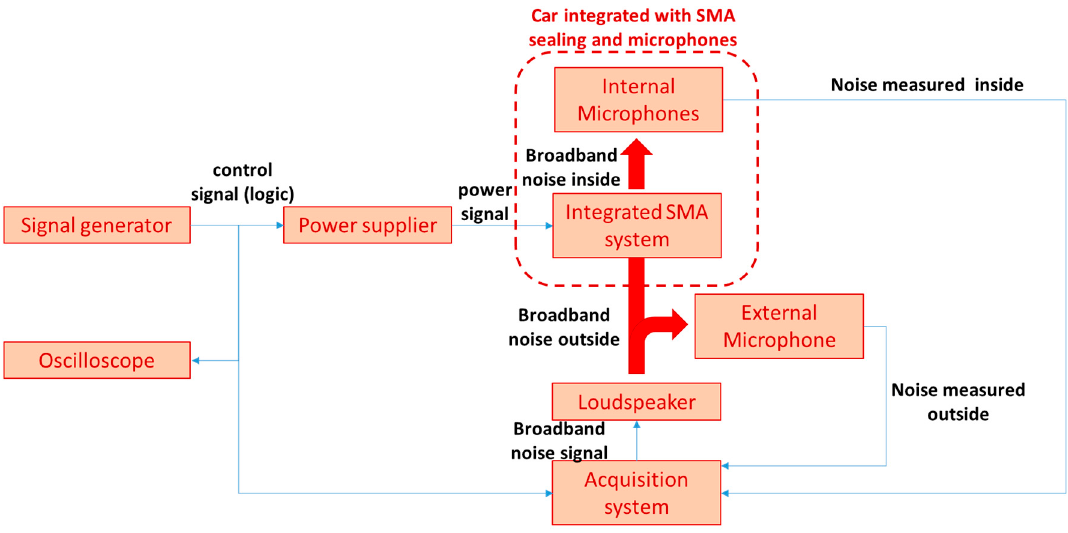
Figure 22. Schematics of the setup for acoustic characterization [30].